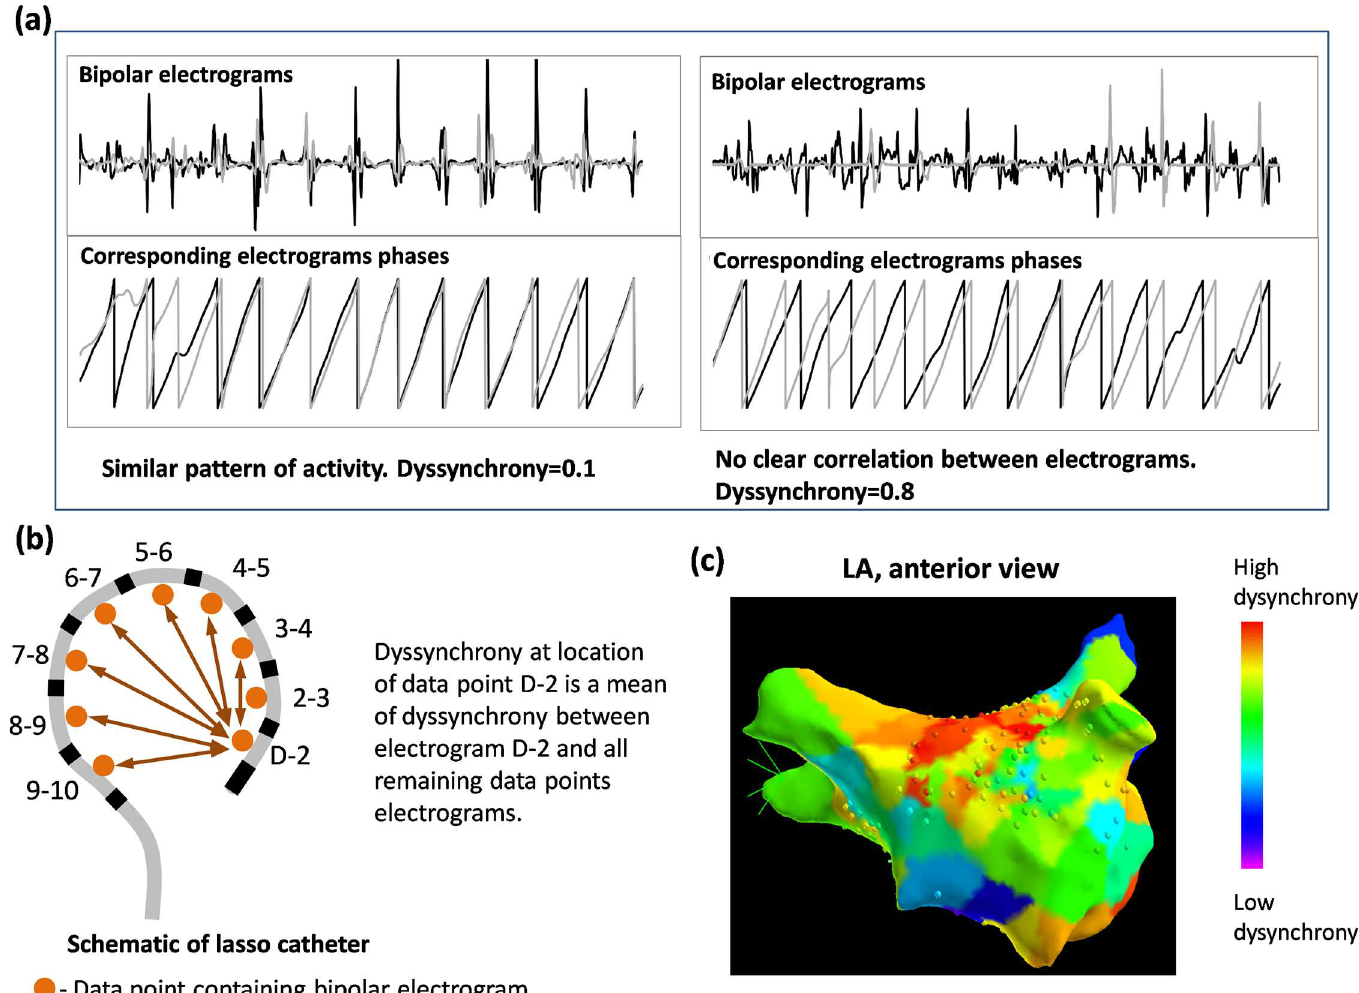
Fig 1. Definition of local electrical dyssynchrony. (a) An example of pairs of electrograms (first electrogram in black, second electrogramin gray) with low (left) and high (right) dyssynchrony level. At the top, originalelectrograms and below corresponding electrograms phases used to compute the dyssynchrony parameter. (b) Schematic of the circular catheter and calculationof dyssynchrony of a given data point (’D-2’ in this example). (c) 3D map with color coded value of electrical